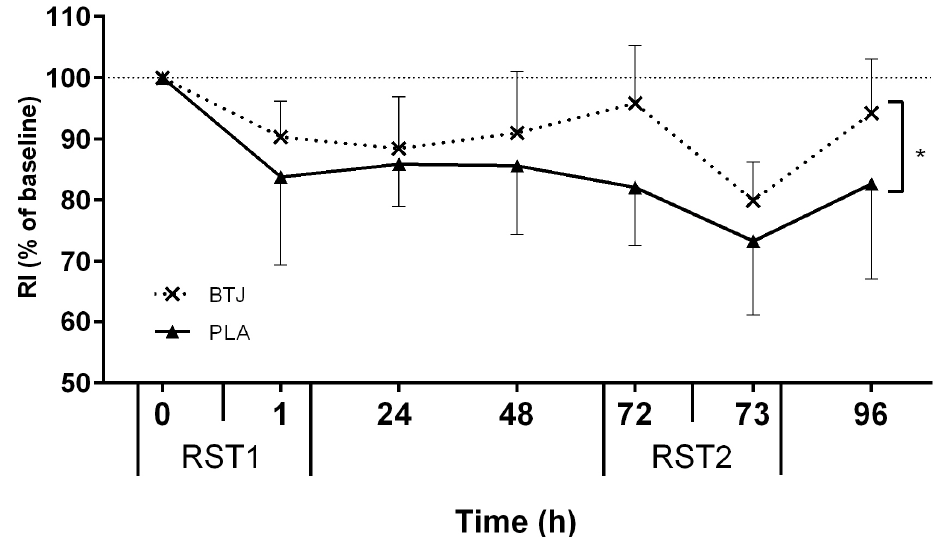
Figure 3. Percentage changes in reactive strength index (RI) between repeated sprint tests (RST1 and RST2). * Represents group difference (beetroot juice (BTJ) vs. placebo (PLA); p < 0.05). Values are mean ± SD ( n = 10 per group).